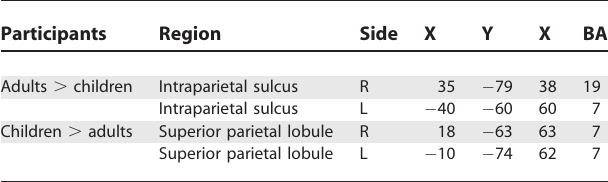
Table 1. Summary of a Random Effects Analyses Contrasting Number-Related Activity in Parietal Regions for Children and